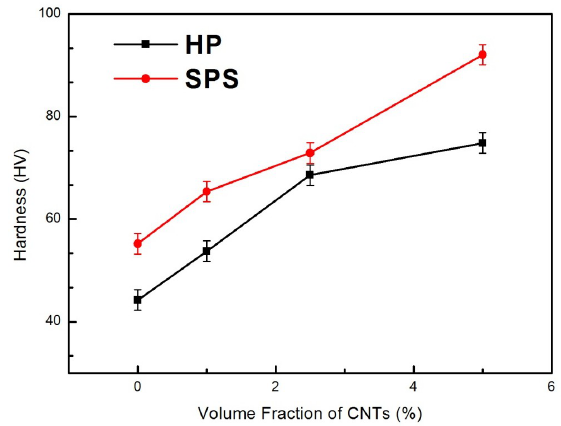
Figure 9. Hardness of the CNTs@Ag/Ag composites prepared via SPS and HP.